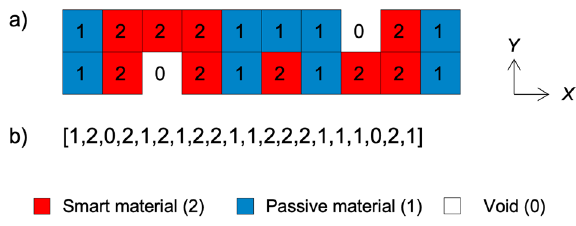
Fig. 1 Genome encoding in the EA. a 2D array of materials distribution and ( b ) its corresponding fl attened 1D list as per usage (seen as a concatenation of each line from left to right following the X direction and from the bottom to the top following the Y